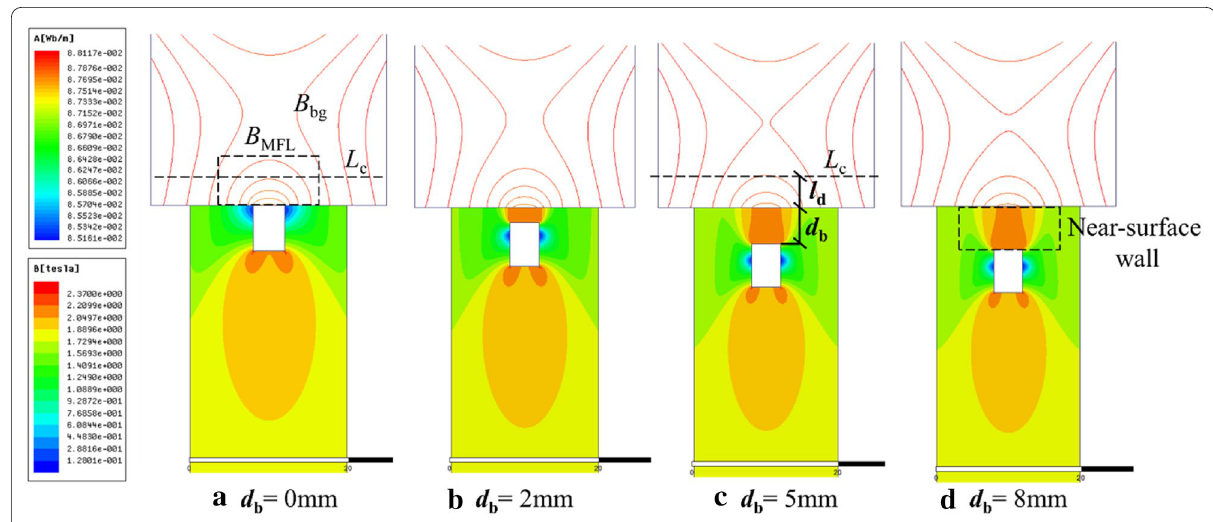
Figure 3 Magnetic flux distributions of inner defects with different buried depths